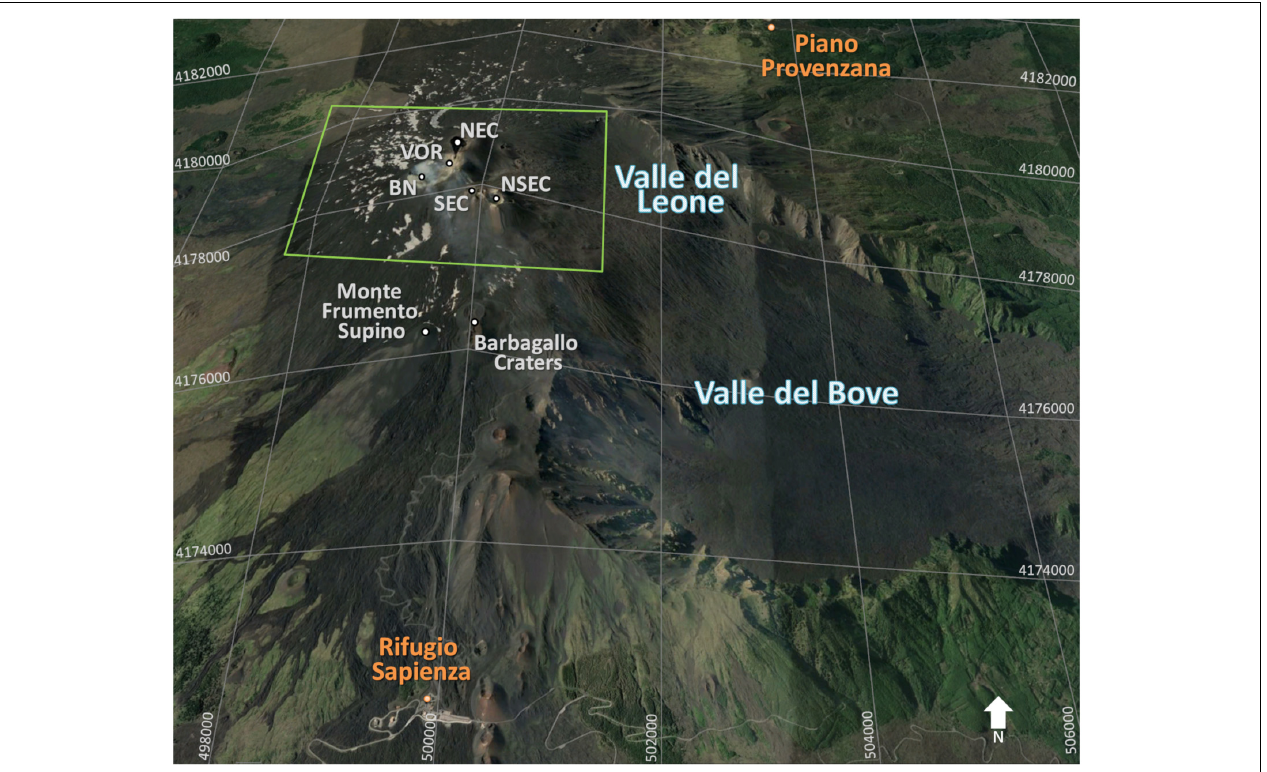
FIGURE 1 | Google Earth 3D oblique view (from south) of Etna’s summit area. The active summit craters are indicated: North-East Crater (NEC), Voragine (VOR), Bocca Nuova (BN), South-East Crater (SEC), and New South-East Crater (NSEC). Monte Frumento Supino and Barbagallo Craters are the cones that diverted the lava flows emitted by NSEC in February and March 2017. Valle del Leone is the NE part of Valle del Bove, a large horseshoe-shaped depression located on the eastern side of the volcano. Rifugio Sapienza and Piano Provenzana are the two main touristic facilities located respectively, in the southern and northern flank of Etna. The green trapeze shows the location of Figure 2